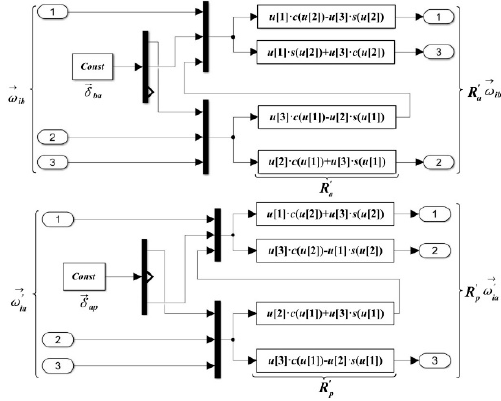
Figure 10. The signals affected by errors of axis perpendicularities.